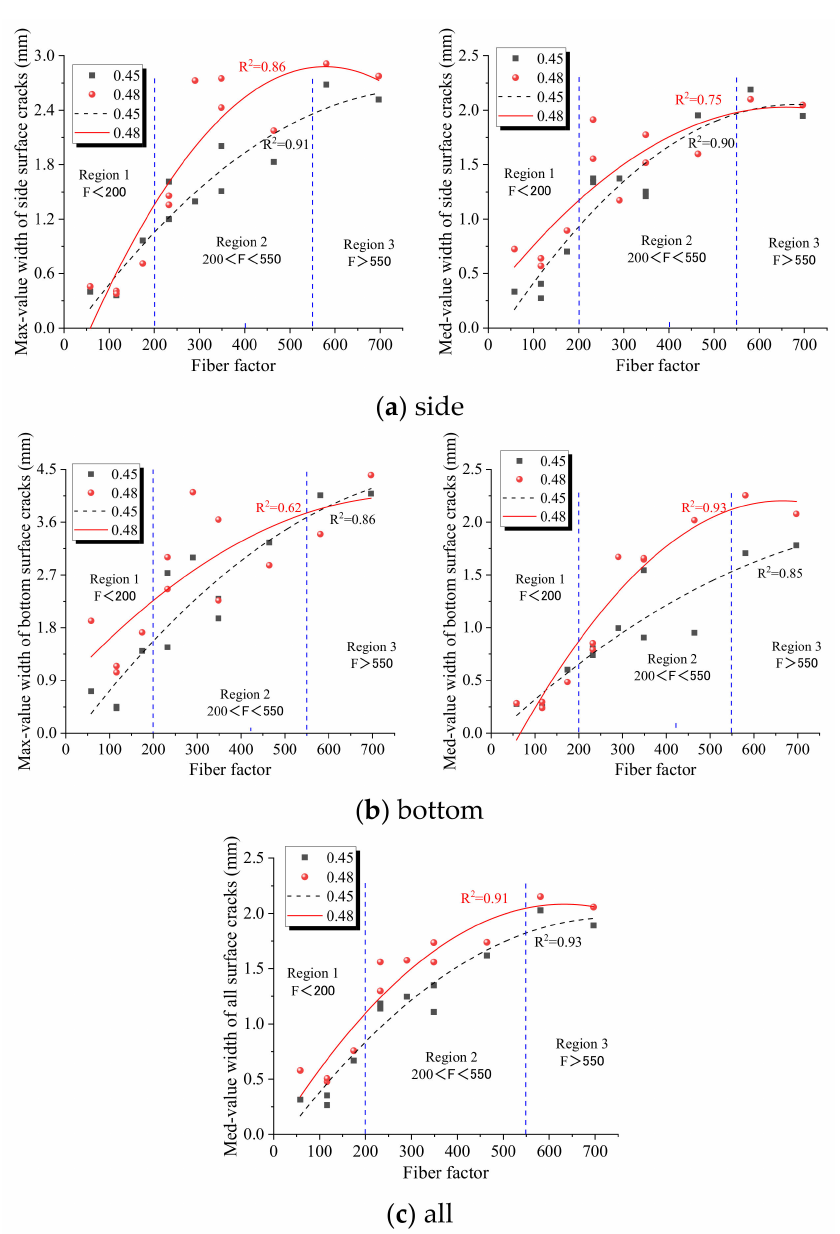
Figure 9. Relationship between fiber factor and crack